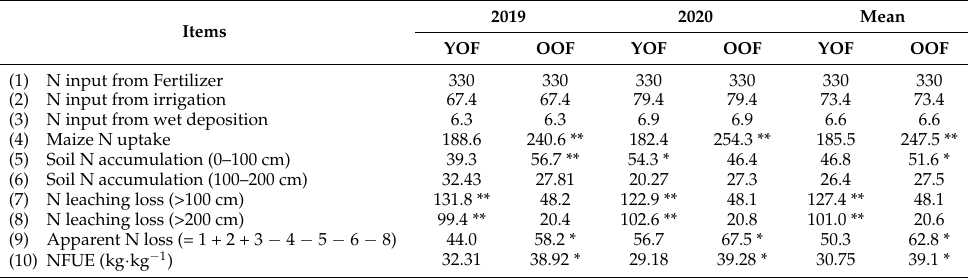
Table 6. Apparent N balance (kg · hm − 2 ) of soil–plant system and NFUE in the YOF and OOF.